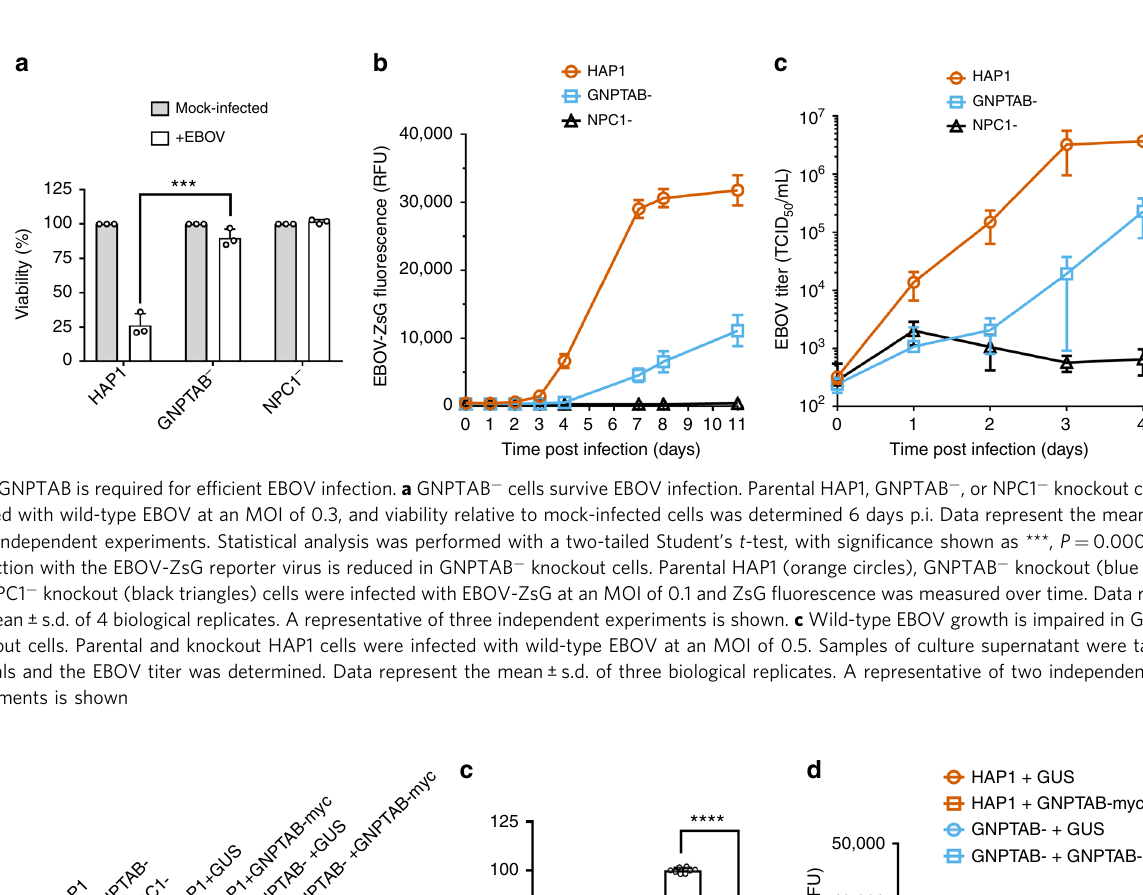
we tested, GM00038. This effect was speci fi c for EBOV, as neither LASV-ZsG nor RVFV-GFP was impaired in MLIII proband cells (Supplementary Figure 6b & f). Yields of AHFV were slightly